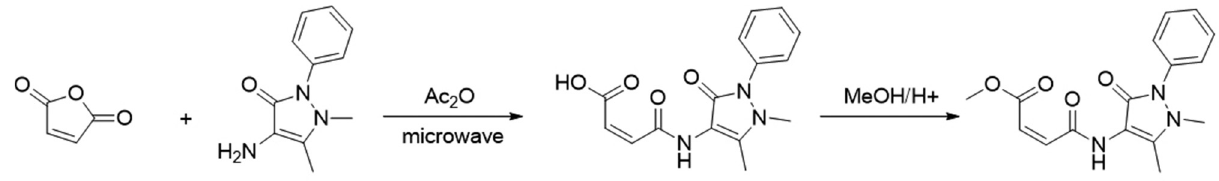
Figure 6 - Synthesis of ester ( Z )-methyl 4-((1,5-dimethyl-3-oxo-2-phenyl-2,3-dihydro-1 H -pyrazol-4-yl)amino)-4-oxobut-2-anoate. Table 1 - Means (cid:3) SE of damaged cells, distribution between damage classes, and scores related to genotoxicity and anti-genotoxicity tests of IR-04 by means of the comet assay. Experimental Groups Damaged cells